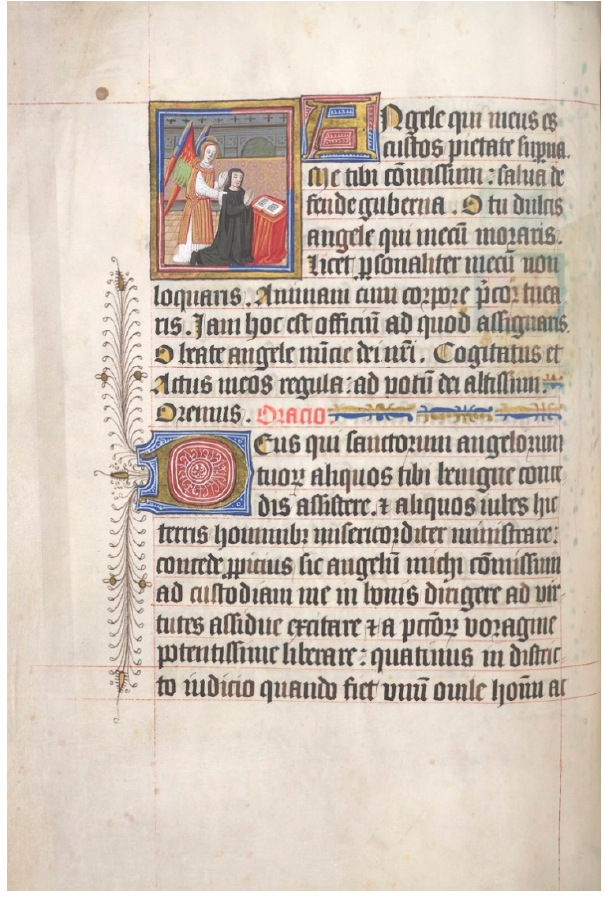
Figure 2. Miniature ahead of the prayer to one’s guardian angel in the Hours of Thomas Butler, f.66v, © British Library Board.